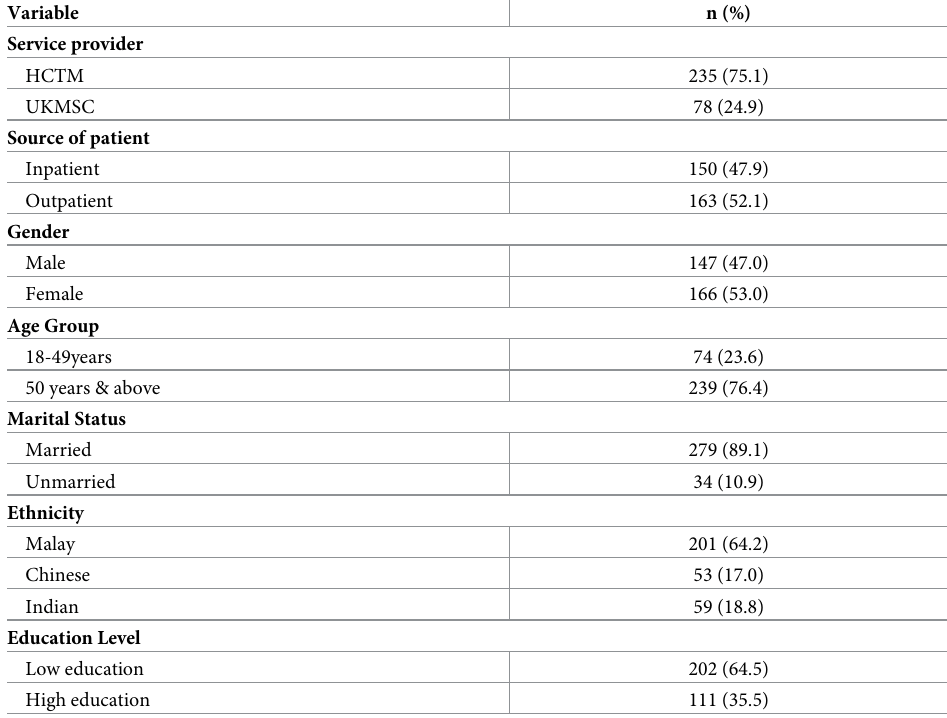
Table 1. Distribution of respondents by sociodemographic